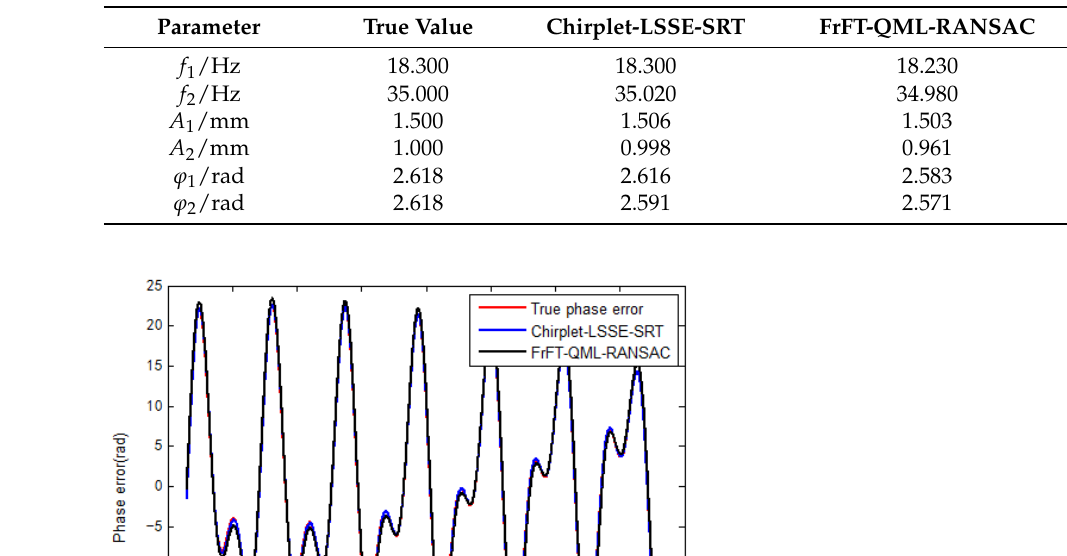
Table 5. Estimate of high-frequency vibration parameters of the distributed imaging scene.